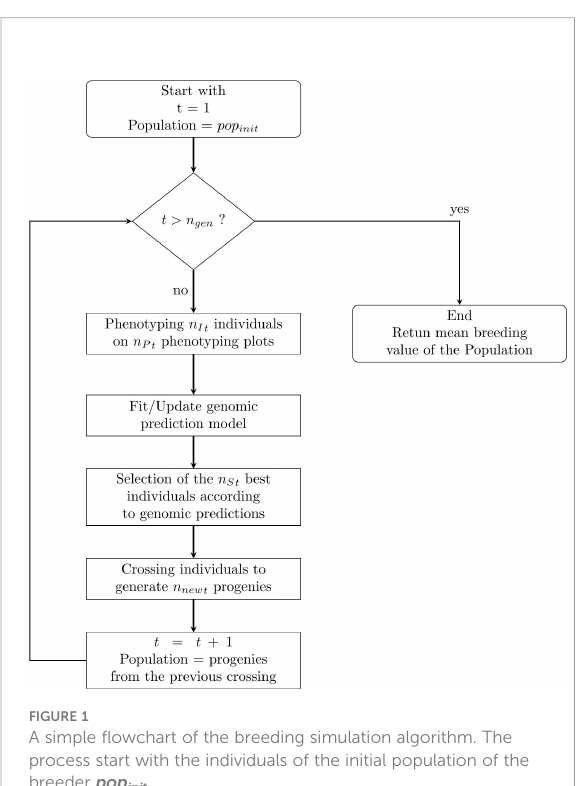
FIGURE 1 A simple fl owchart of the breeding simulation algorithm. The process start with the individuals of the initial population of the breeder pop init